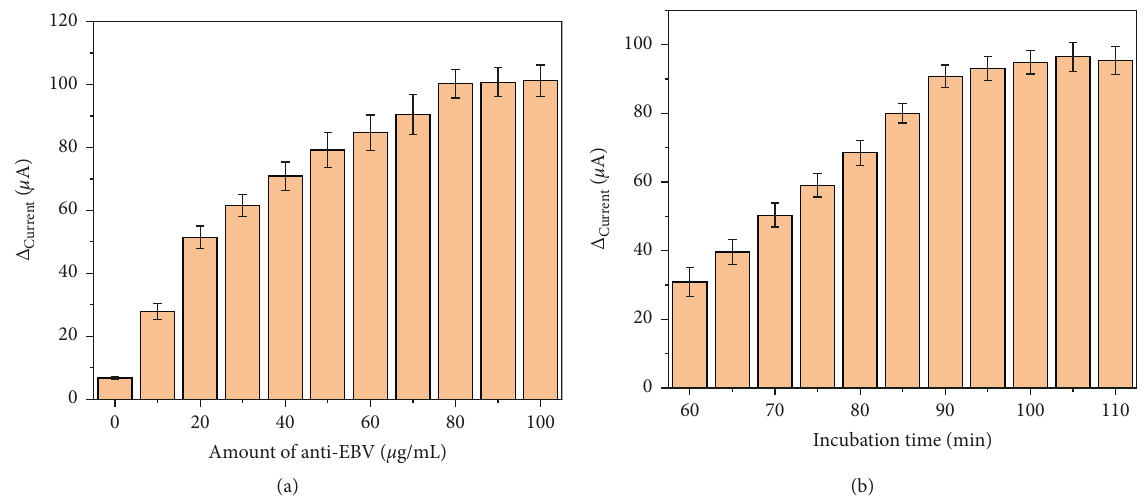
Figure 5: Effect of (a) the amount and (b) immobilization time of anti-EBV in the sensor performance.